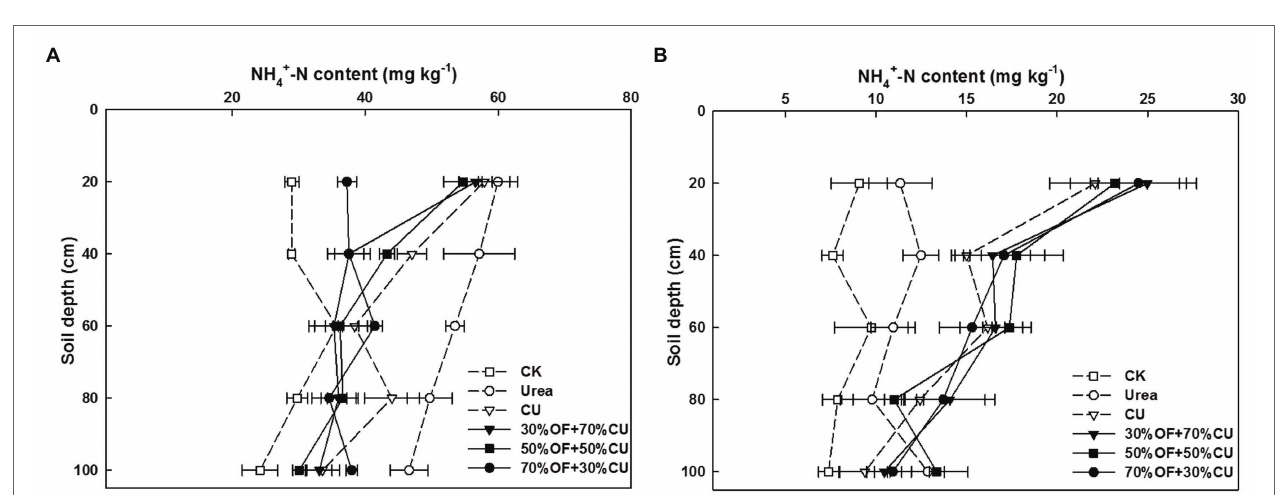
FIGURE 10 | The distributions of soil + NH 4 -N in the 0–100-cm soil profiles at the seedling stage (A) and mature stage (B) in